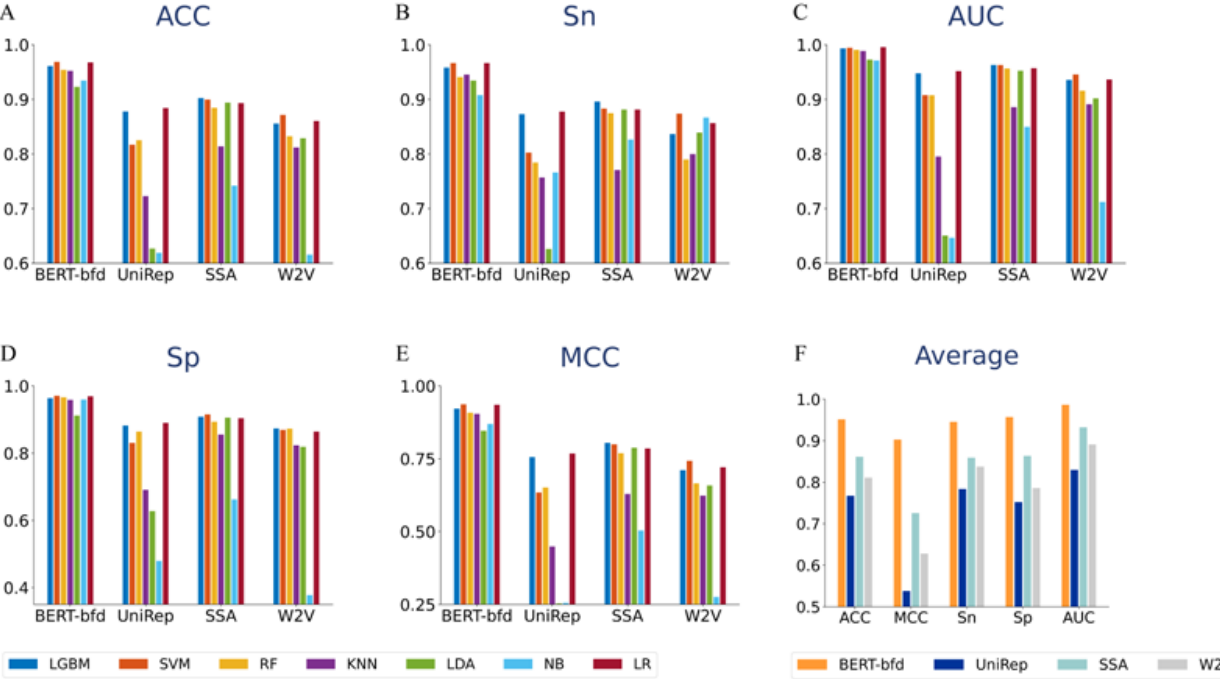
Figure 3. Performance of models using BERT-bfd and other deep representation learning features, UniRep, SSA, and W2V, with seven different classifiers. ( A ) is the histogram of ACC. ( B ) is the histogram of Sn. ( C ) is the histogram of AUC. ( D ) is the histogram of Sp. ( E ) is the histogram of MCC. ( F ) is the histogram of average performance of seven different classifiers.